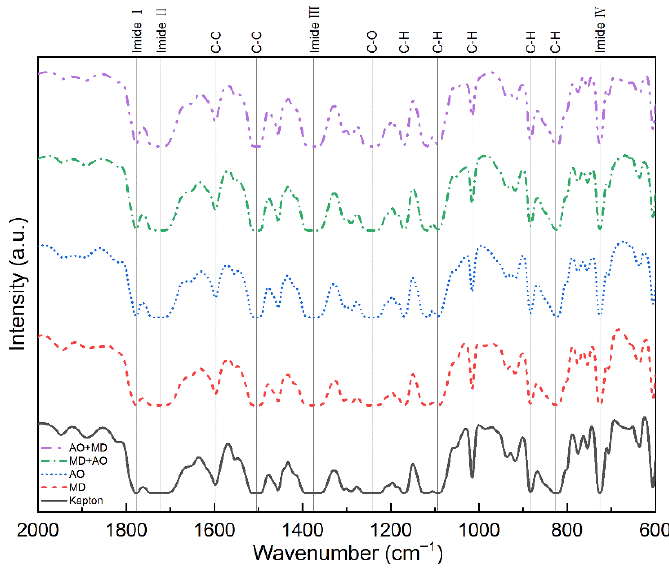
Figure 9. Infrared spectra of Kapton film before and after different load spectrum tests.